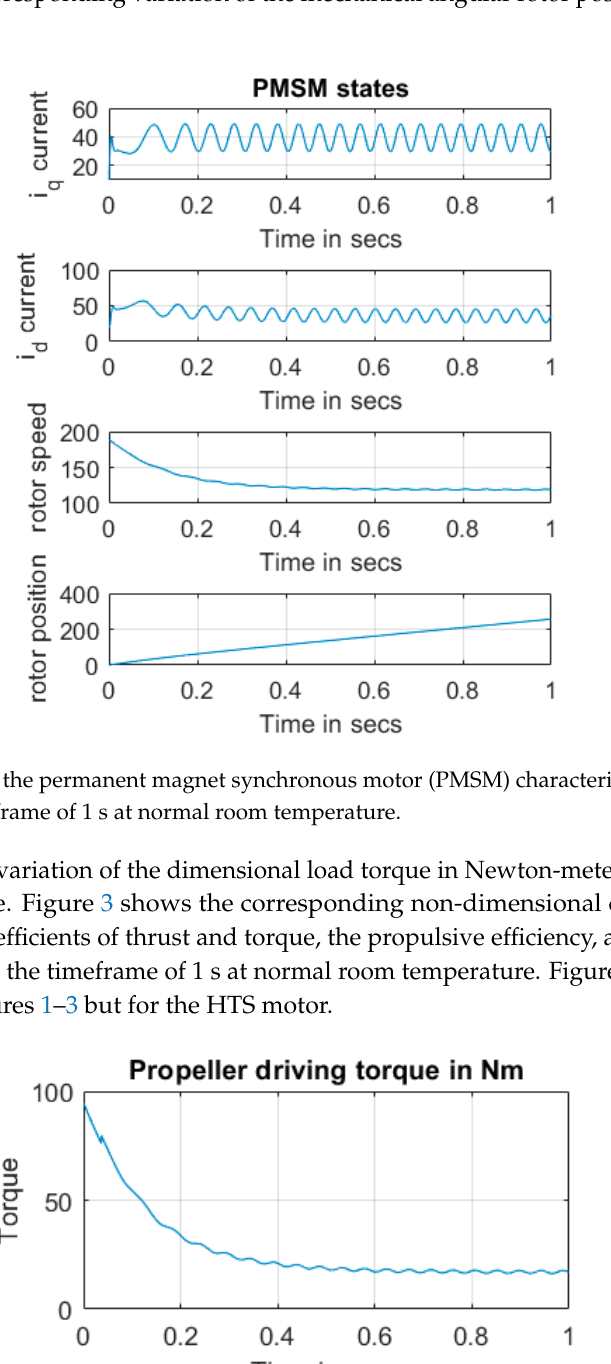
Figure 3. Variation of the PMSM-driven propeller non-dimensional coefficients of thrust and torque, propulsive efficiency, and advance ratio as a function of time over the timeframe of 1 s at normal room temperature.